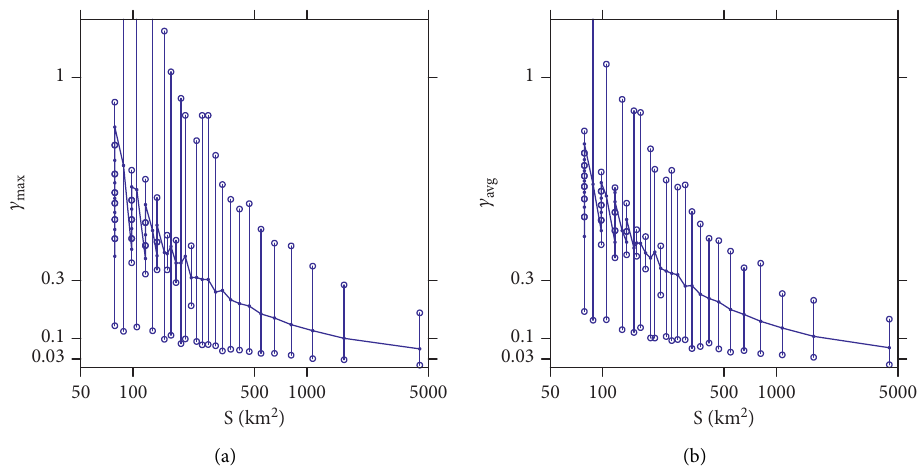
Figure 9: The relationship between c of same samples in each interval at x axis.